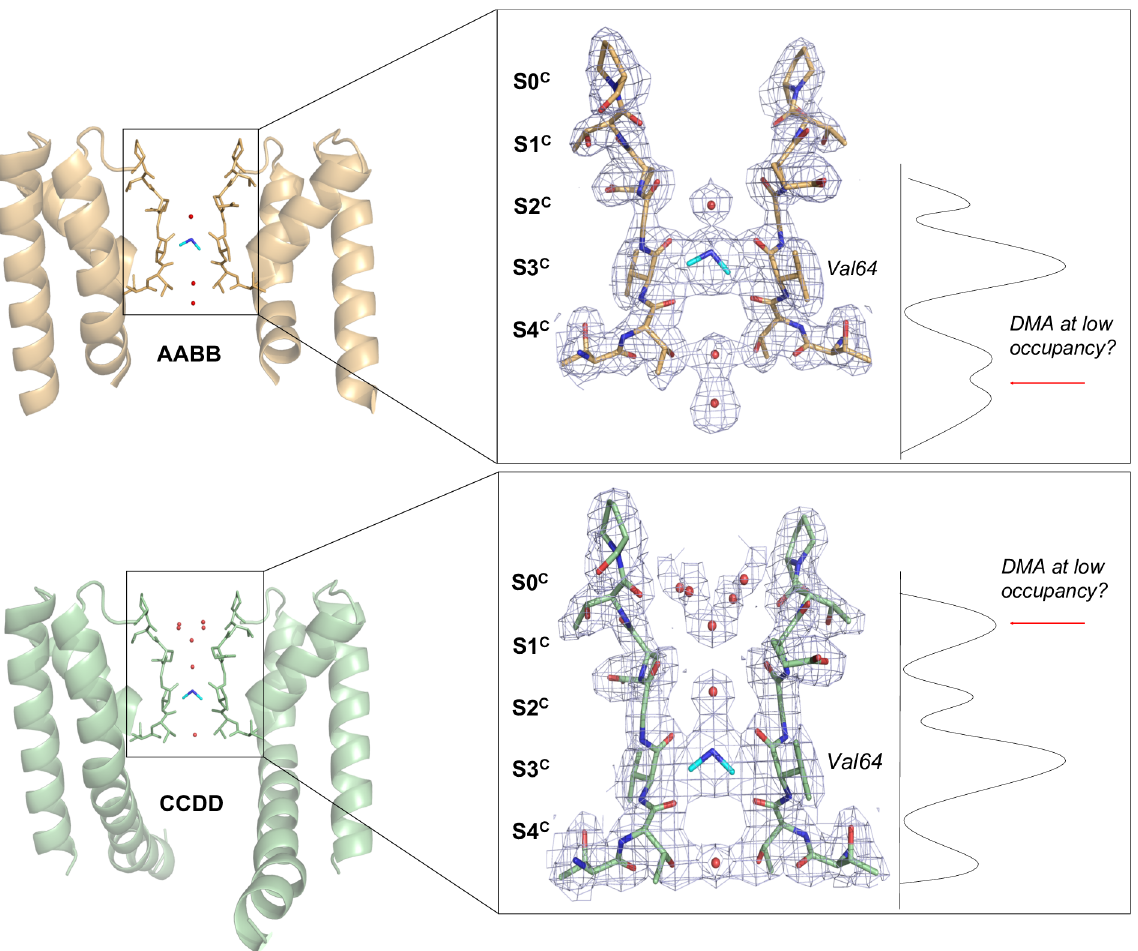
Fig 1. Crystal structure of the CNG-mimic:DMA complex. Overview of the AABB and CCDD NaK2CNG tetrameric structures (PDB ID: 4R7C) showing only two monomers for clarity; residues in the selectivity filter are shown as sticks. The black box indicates the region expanded in the right panel, corresponding to the selectivity filter. On the right of each molecule, the one-dimensional electron density profile along the axis of symmetry is reported. The DMA cation is shown in cyan and well-ordered water molecules are shown as red spheres. The crystallographic sites are labeled S0-4 c , starting from the extracellular side. The final refined 2Fo-Fc electron density maps are shown at 1.3 σ in light blue mesh. The position of Val64 is indicated.